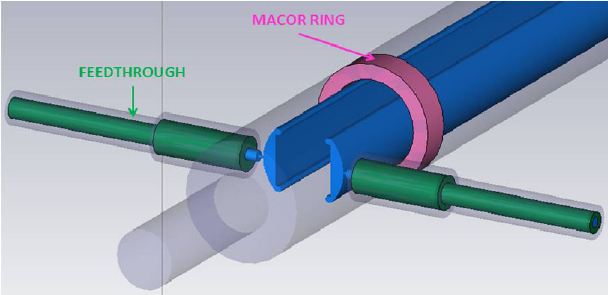
FIG. 17. CST MS model used to optimize the electrode supports and the feedthroughs for the half-moon